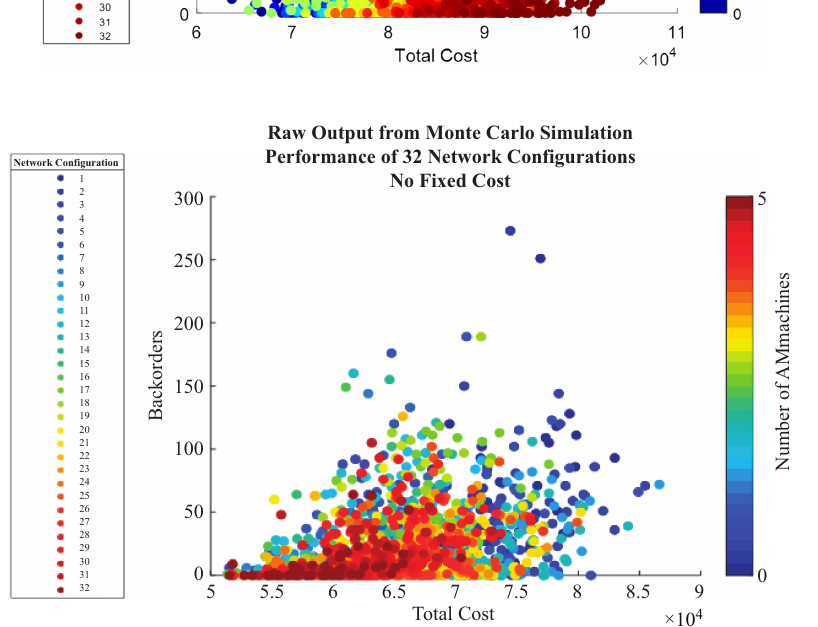
Figure 5. (Color online) Monte Carlo simulation raw output results. Data points are grouped by each of the 32 network configurations